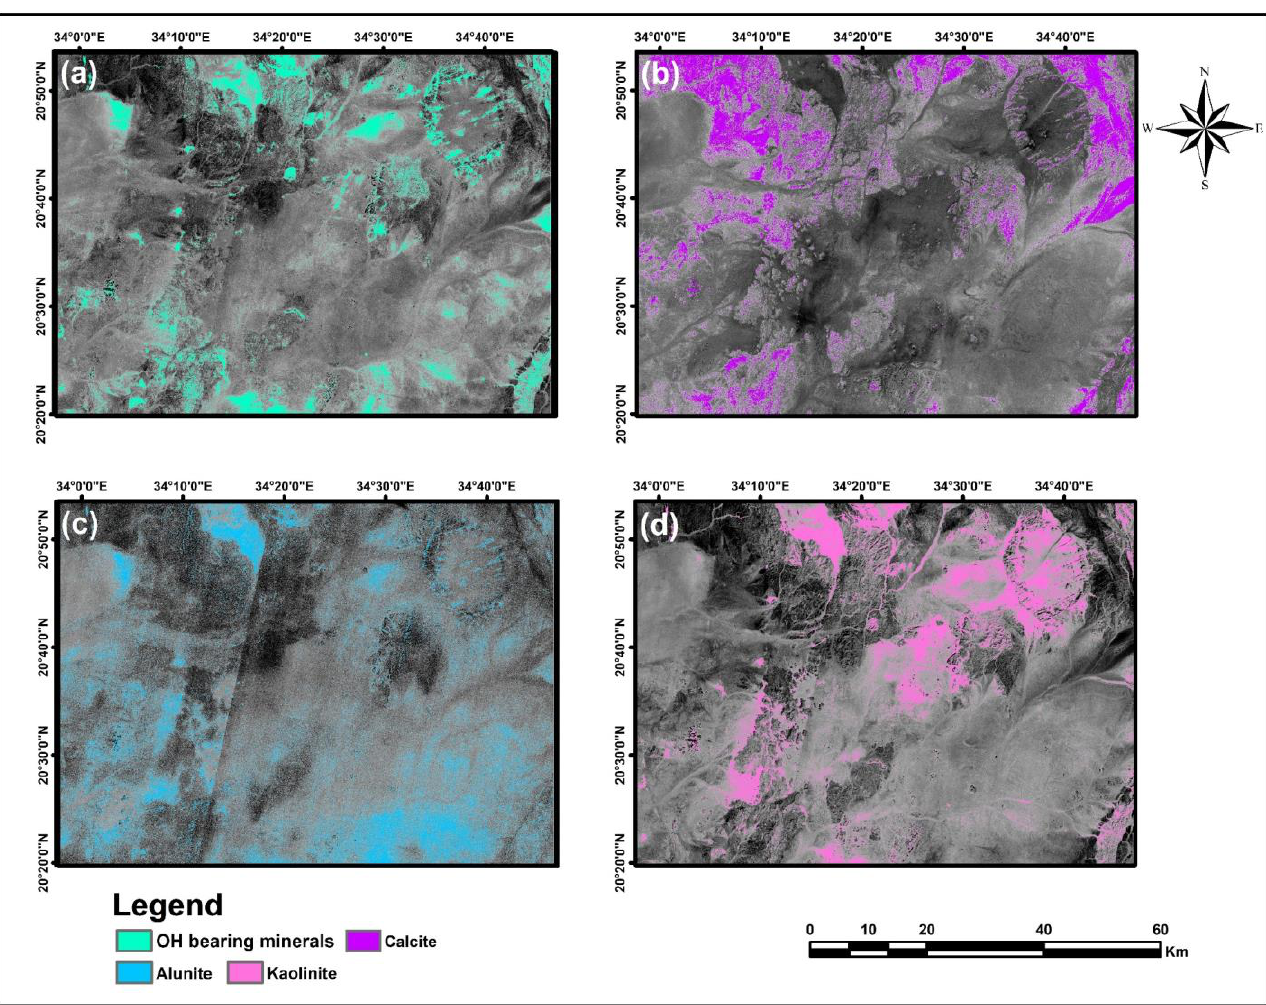
Figure 6. The mineralogical indices images derived from ASTER SWIR bands show the spatial dis- tribution of targeted minerals in colored pixels: ( a ) OHI; ( b ) CLI; ( c ) ALI; ( d )